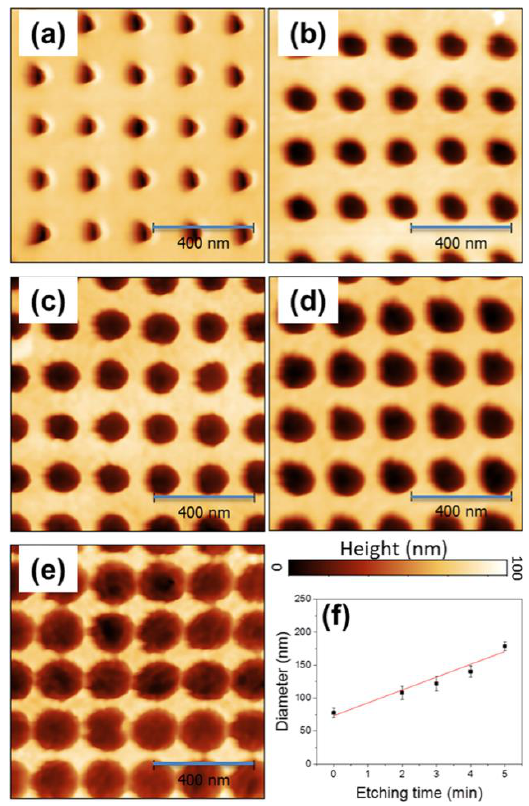
Figure 15. Atomic force microscopy (AFM) images of fabricated polyacrylonitrile PAN nanohole structures with etching times of ( a ) 0, ( b ) 2, ( c ) 3, ( d ) 4, and ( e ) 5 min. ( f ) Nanohole diameters as a function of etching time. The red line corresponds to a linear fit of the data [91].